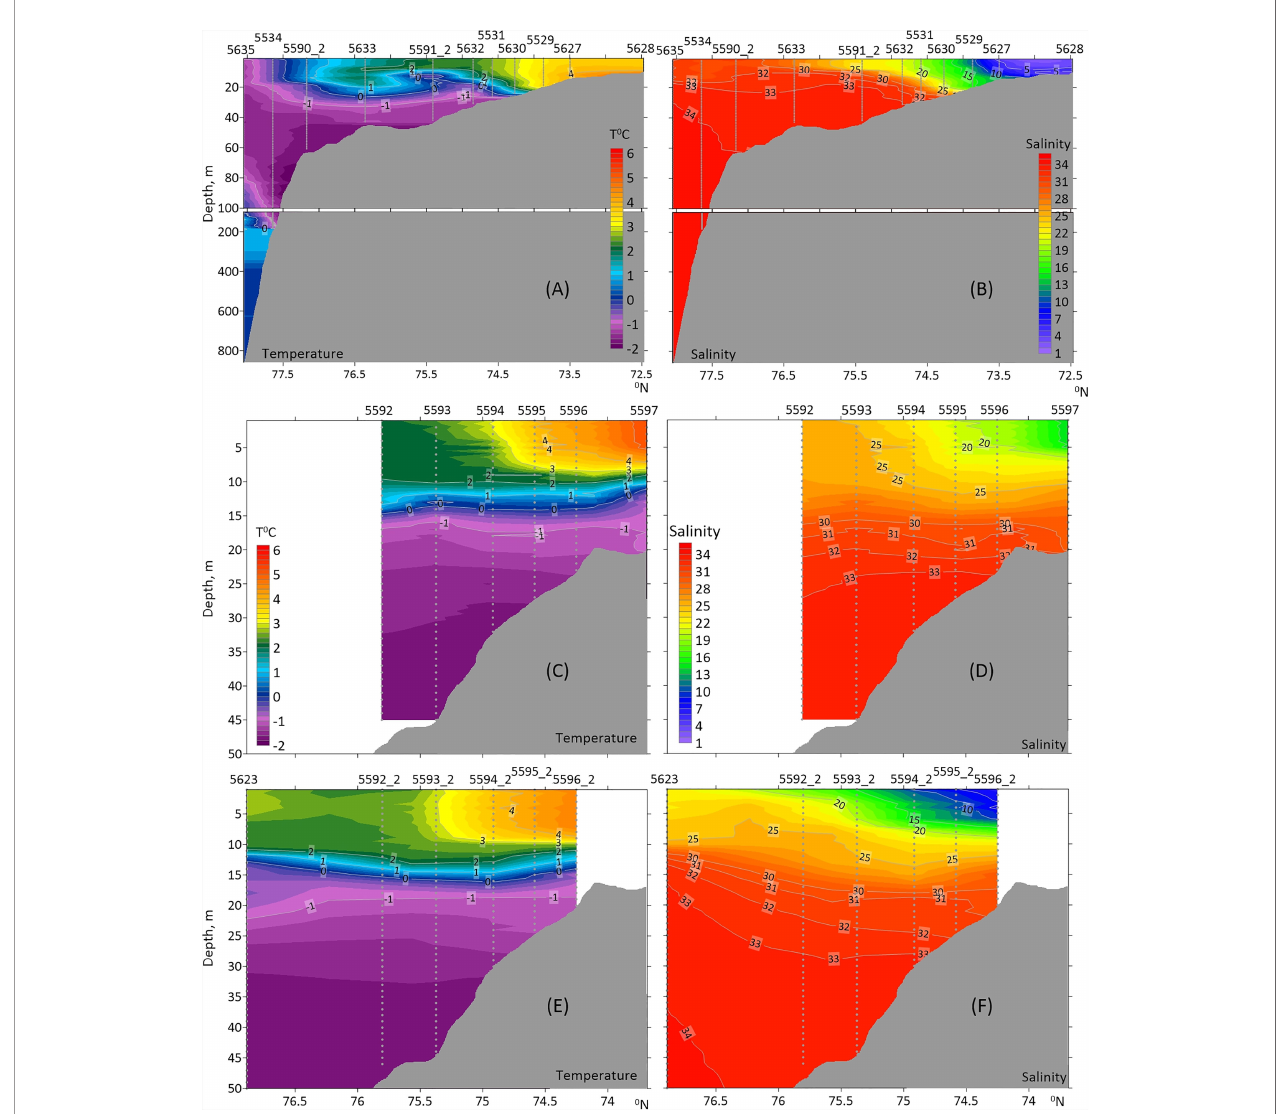
FIGURE 2 | Distribution of salinity (left) and temperature (right) along the transects. (A, B) – Khatanga transect (17-20 September); (C, D) – Lena transect (2-3 September); (E, F) – Lena transect (14-15 September). Redrawn from: Flint et al., 2018. Considerable changes in the distribution of the freshened upper mixed layer are recognized in the Lena area at the second sampling. The distribution of salinity – temperature parameters in the Khatanga area could not be presented as only two stations were